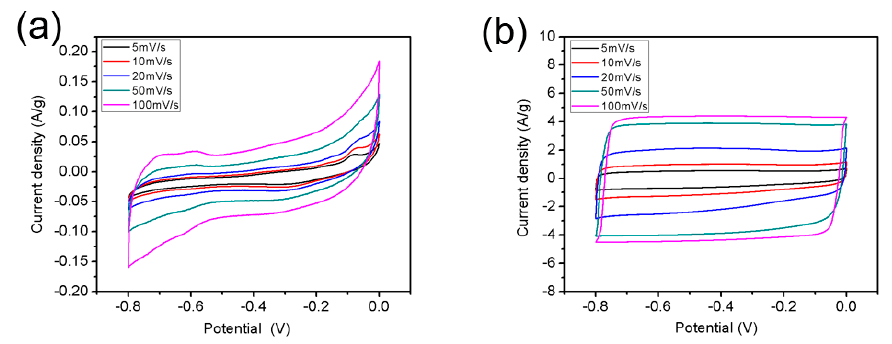
Figure 9. CV curves of GO ( a ) and r-GO ( b ) at various scan rates from 5 to 100 mV/s.